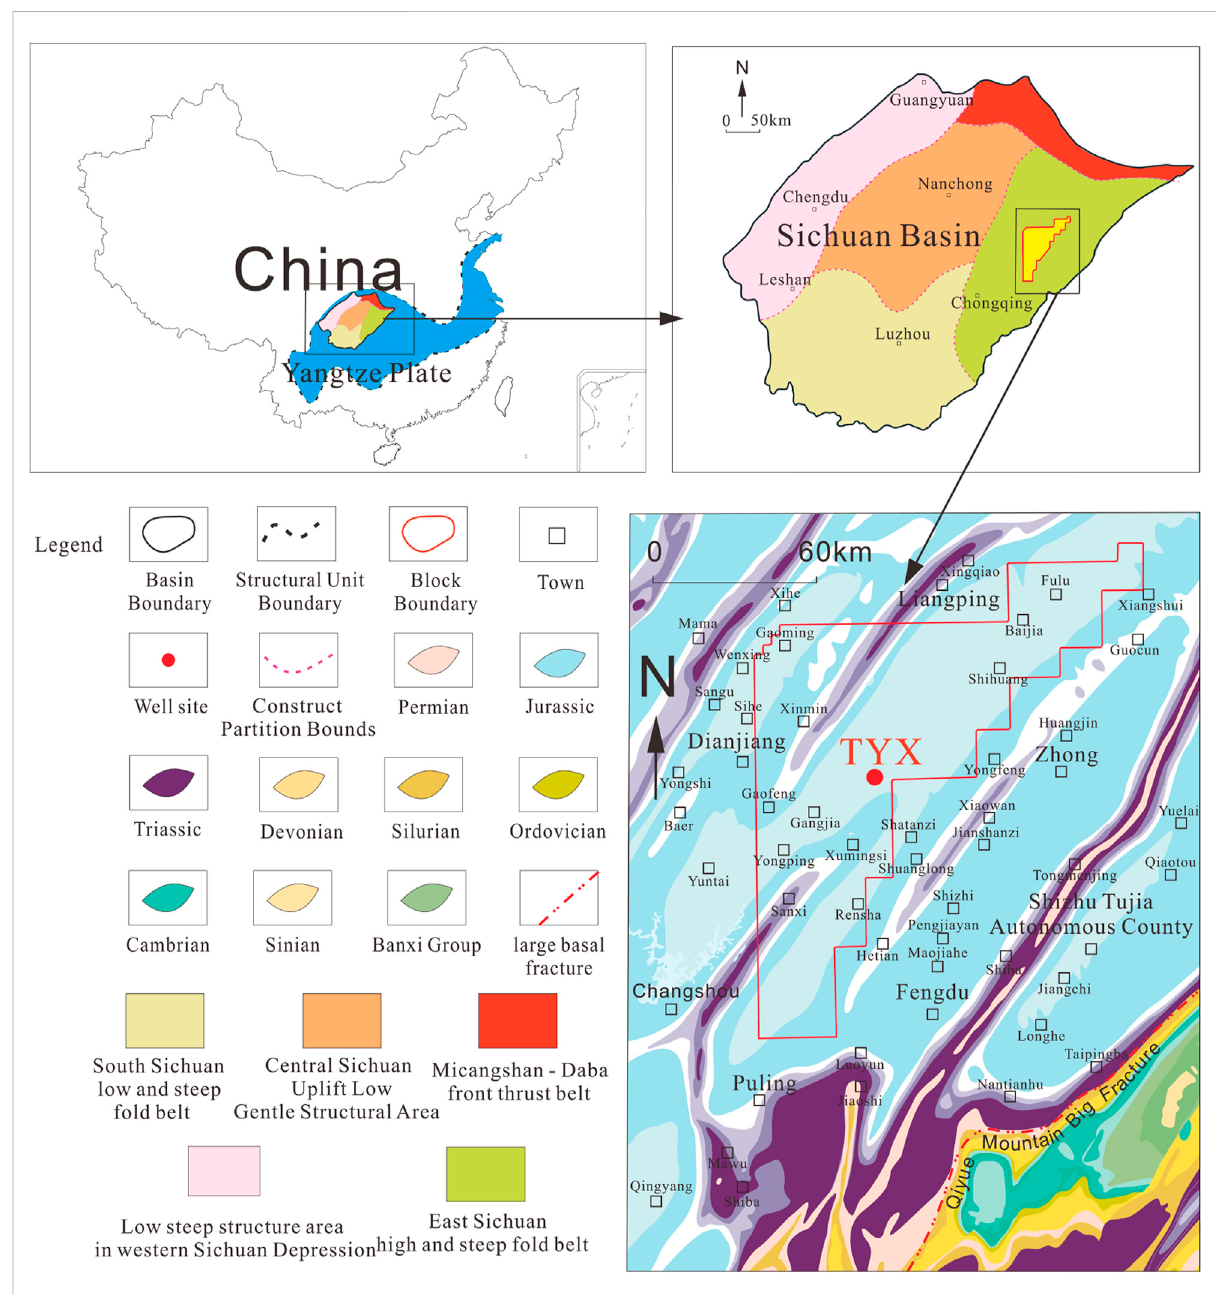
FIGURE 1 LocationoftheFulingblockandthedistributionofTYXwellsitesinthesoutheastofSichuanBasin,SouthChina.Modi fi edfromreferences(Guo et al., 2016; Guo et al., 2017; Liu W. et al., 2021; Wei et al., 2021; Zhang et al.,